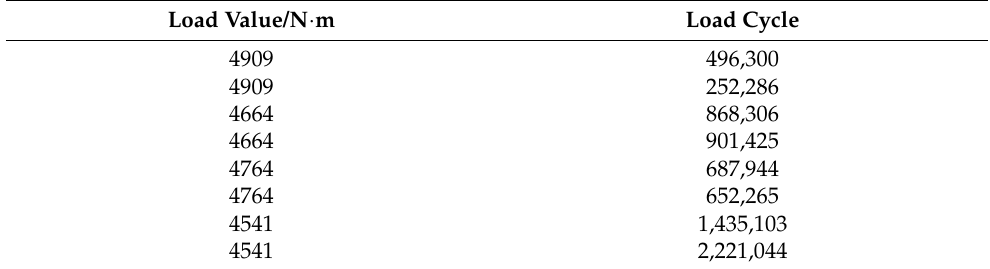
Table 6. Fatigue experimental results of crankshaft N1.